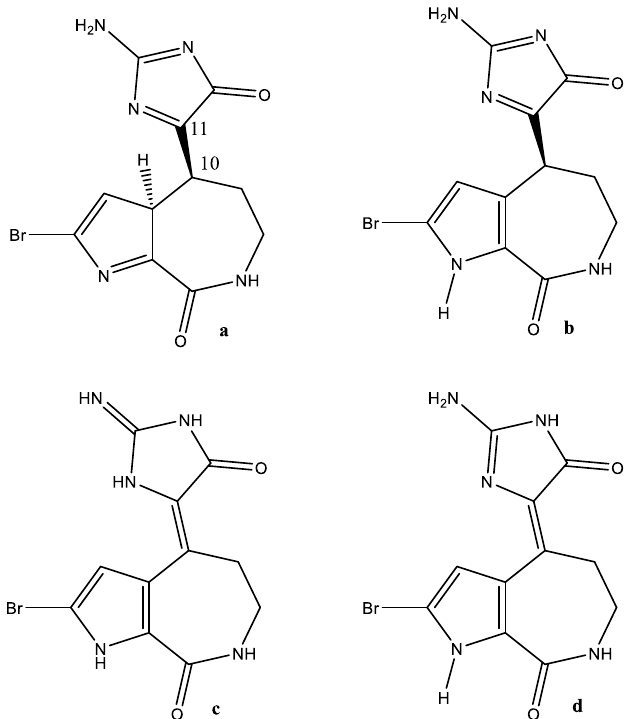
Figure 22. Different presentations of hymenialdisine. The odd form ( a ) is from Ref. [95].